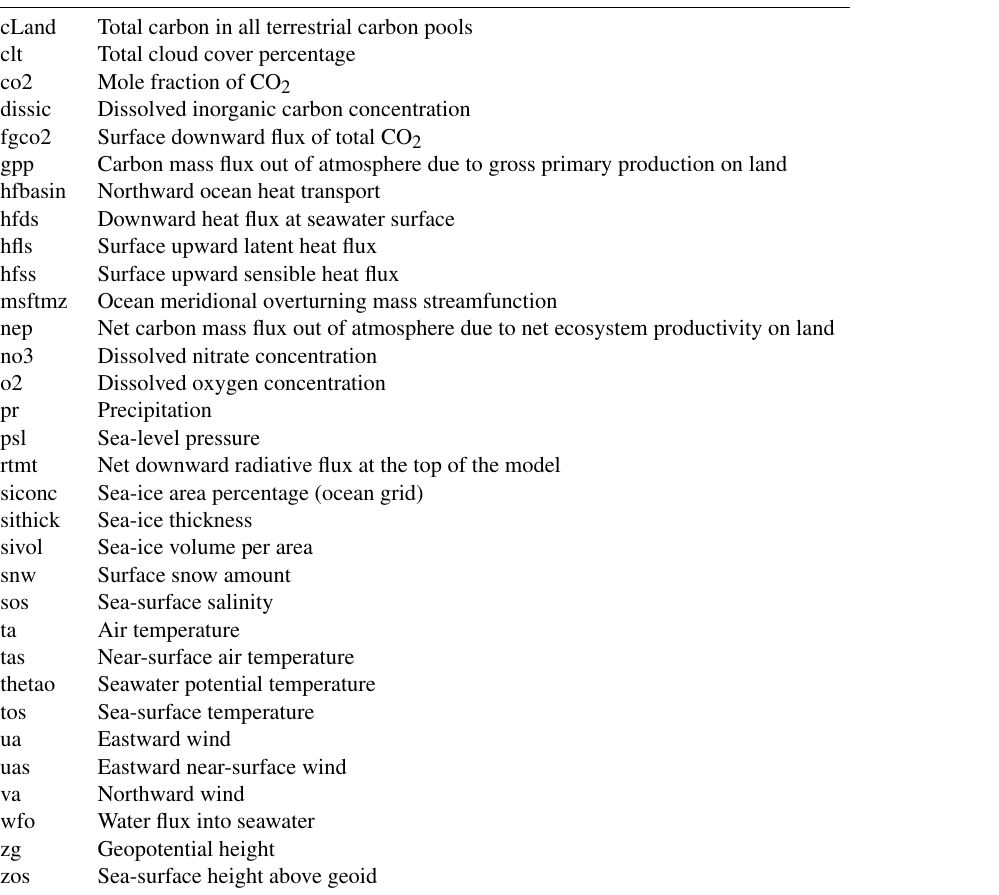
Table F3. List of CMIP6 variable names used and their long